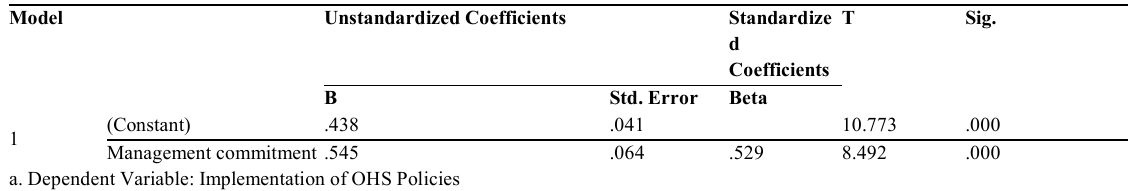
Table 4: Beta Results for Relationship between Management Commitment and Implementation of OHS Policies